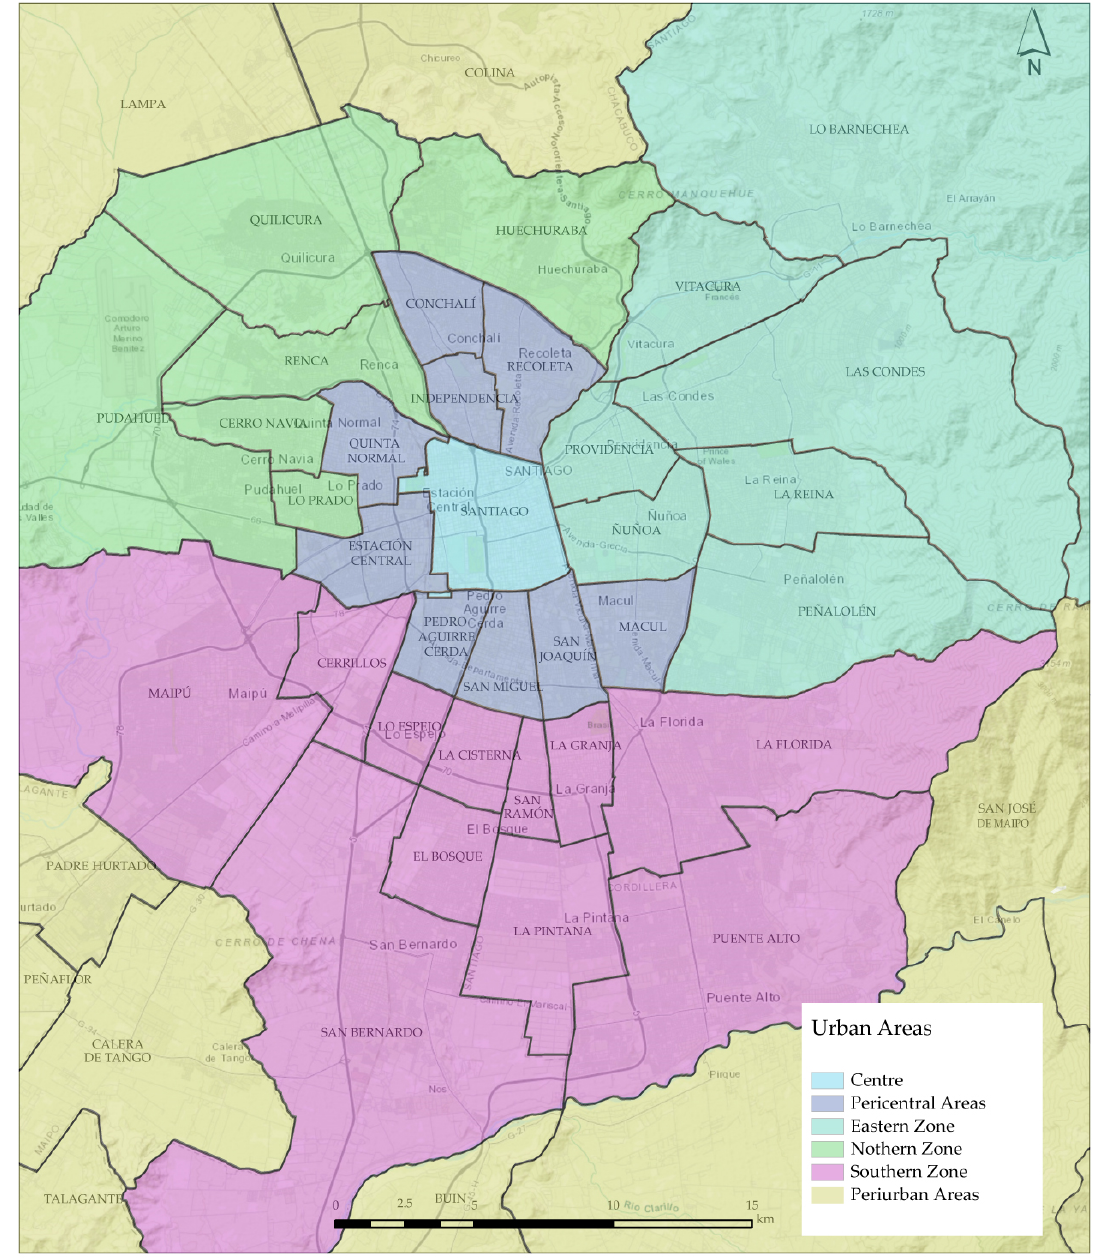
Figure 2. Urban zones from the metropolitan area of Santiago de Chile.